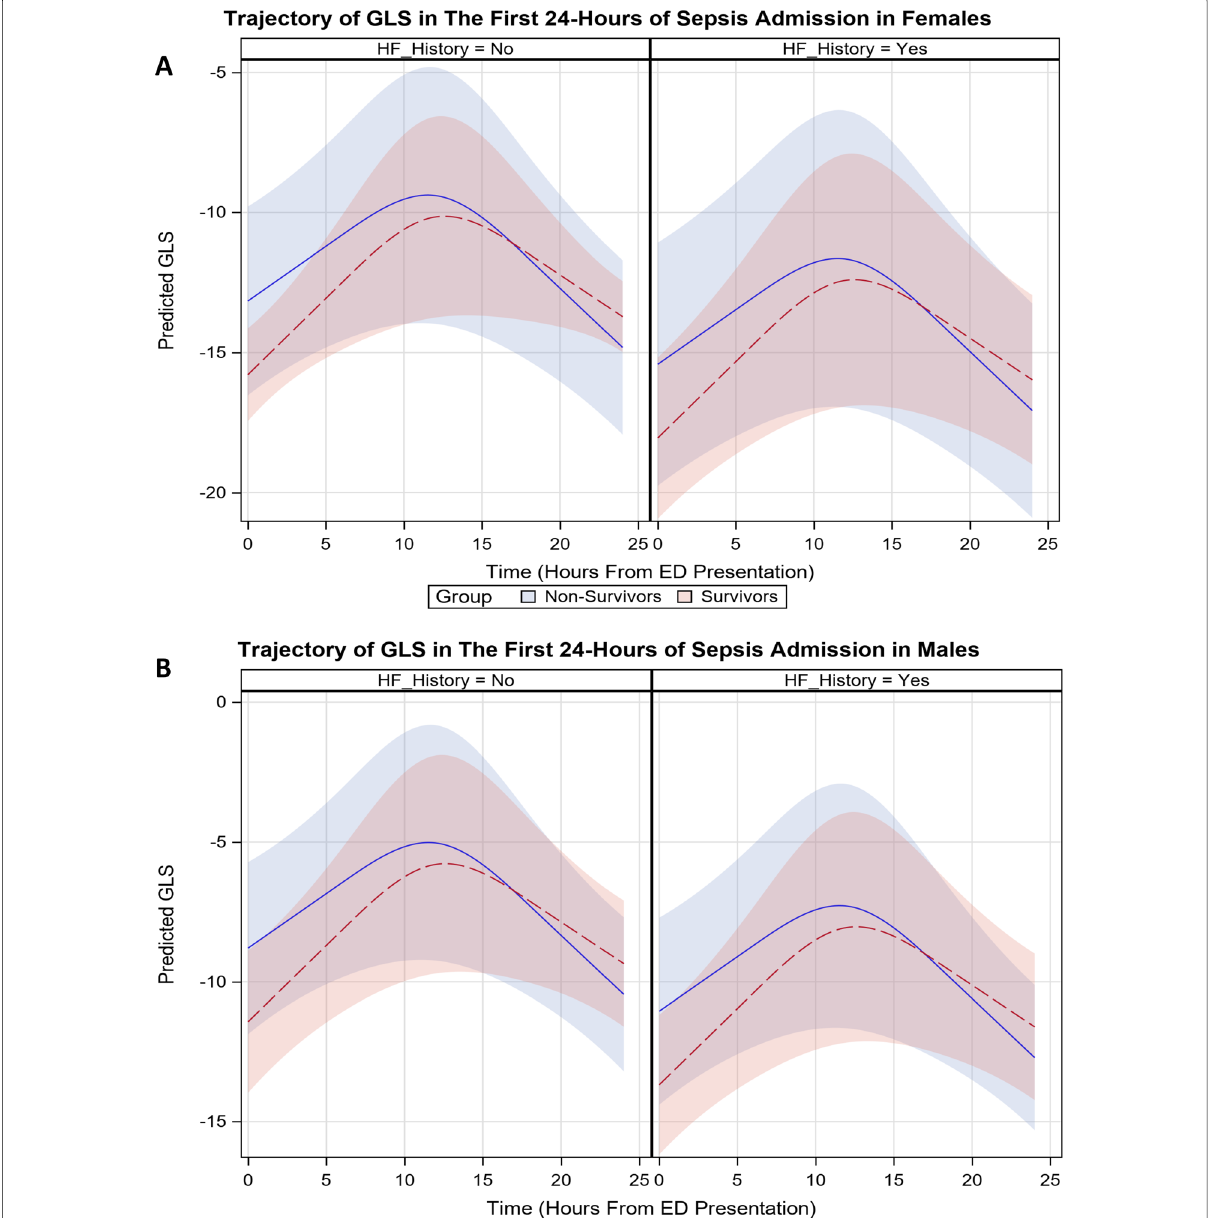
Fig. 2 Trajectory of model-predicted global longitudinal strain during the first 24 h of admission. Time–death interaction plot showing a different trajectory of predicted GLS in survivors versus non-survivors, adjusted for age, biologic sex, ED SOFA score, ED Troponin-I, IV volume given in 24 h, and baseline IVC collapsibility, stratified by heart failure history; bands represent 95% CIs. A depicts the relationship in females; B depicts the relationship in